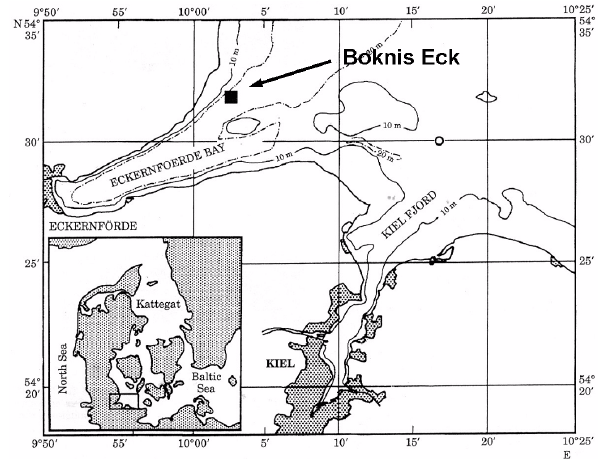
Fig. 1. Location (black square) of the time series station Boknis Eck in the Eckernf ¨ orde Bay (SW Baltic